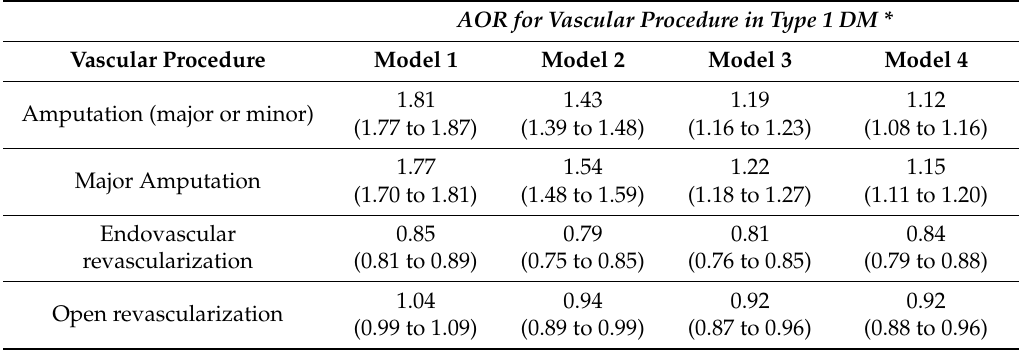
Table 2. Association of type 1 diabetes with the type of procedure utilized during